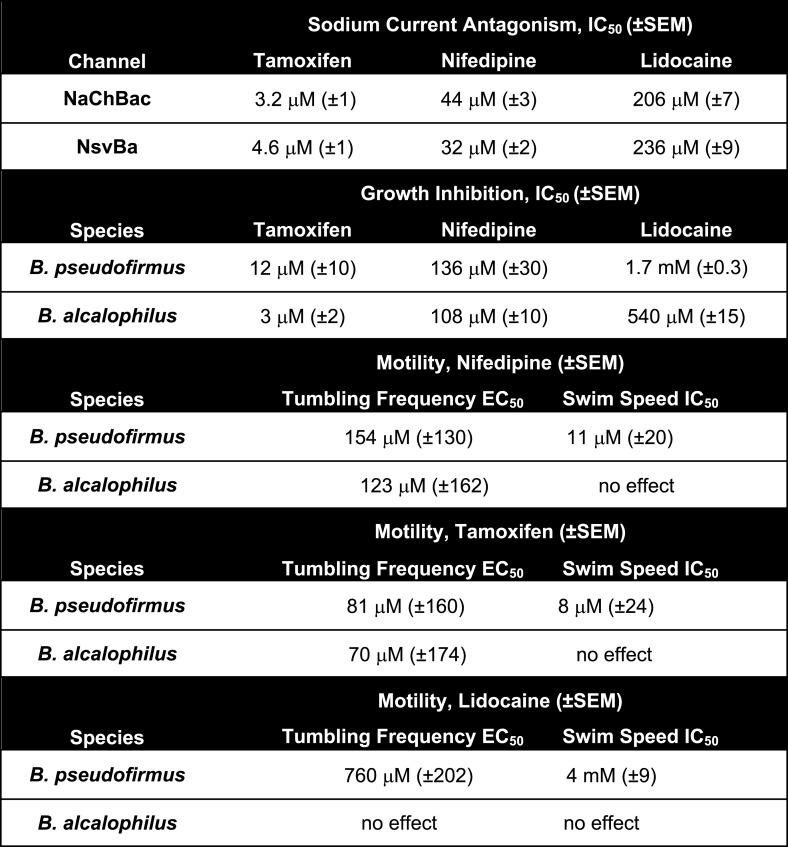
The effect of Nav antagonist on INa, bacteria motility and growth by drugs: lidocaine, tamoxifen and nifedipine.